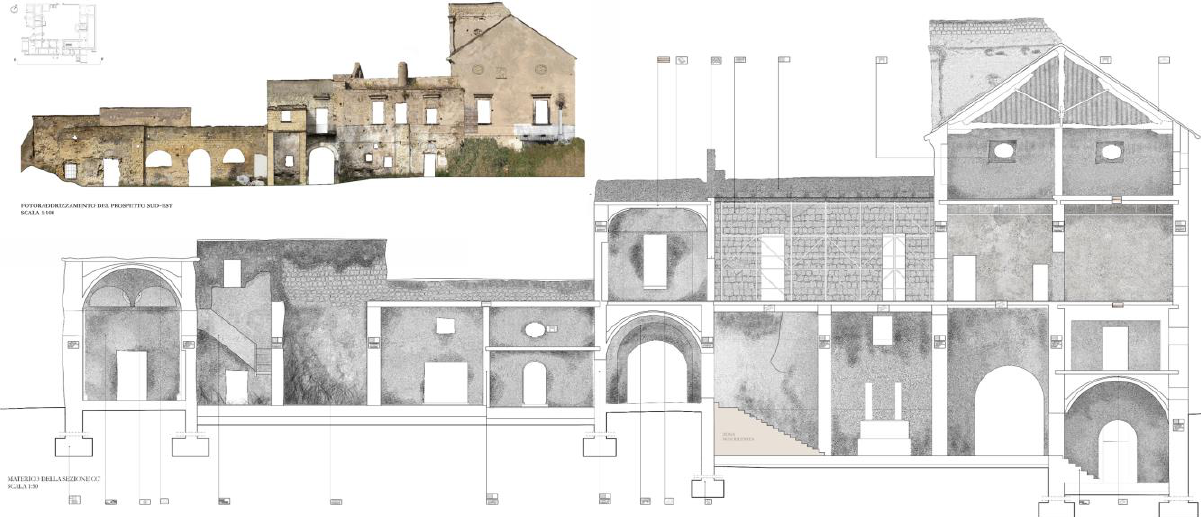
Figure 6. F. Amoddio, C. Barone, M. Bosone, F. Di Lorenzo, M. Franceschetti, Degree thesis in Architecture 5 UE, University of